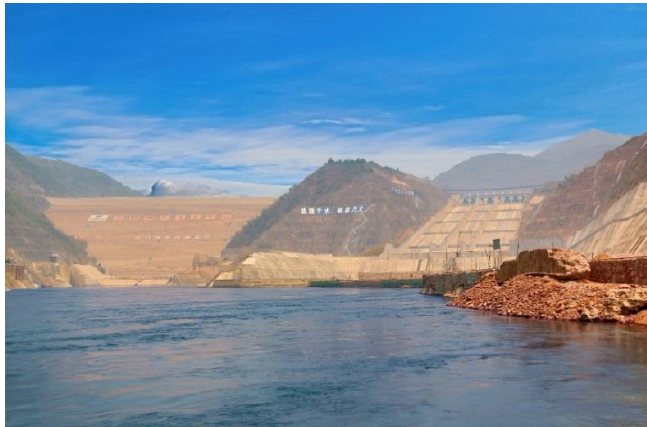
Figure 1. Nuozhadu Hydropower Station.